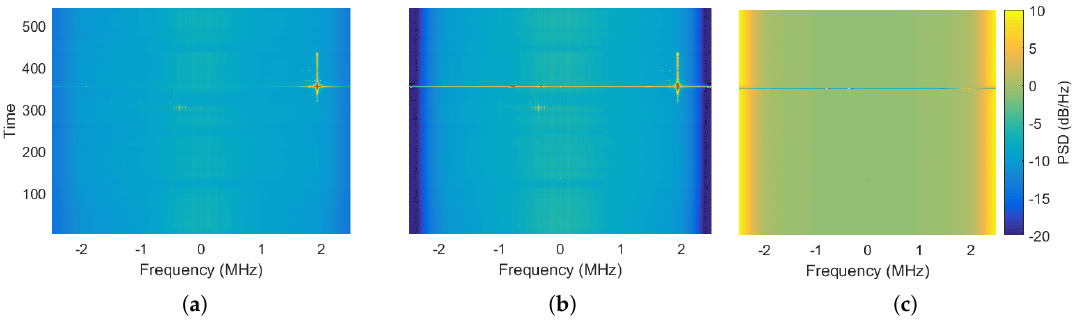
Figure 12. Test case for the urban environment. Spectrogram of the ( a ) recorded and ( b ) re-recorded GNSS raw samples. ( c ) Difference between the two